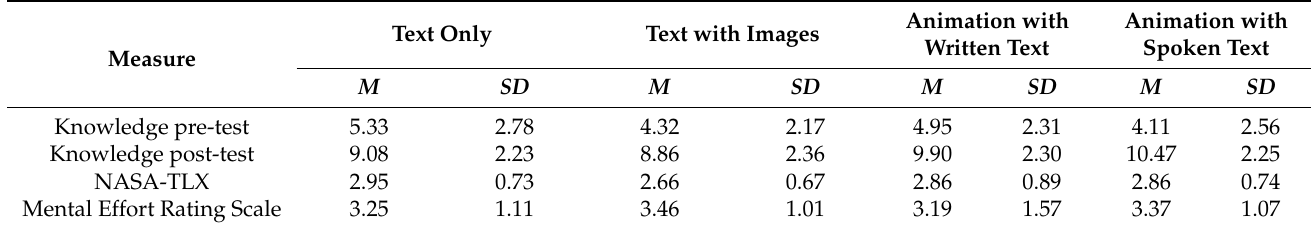
Table 1. Descriptive data of study 1 in group